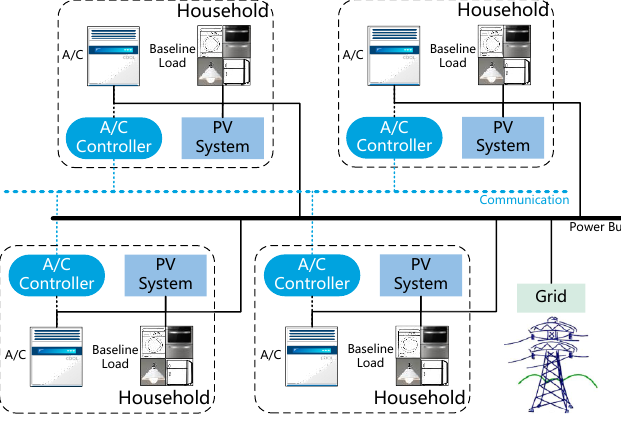
Figure 1. Structure of the smart community. A/C: air conditioning; PV: